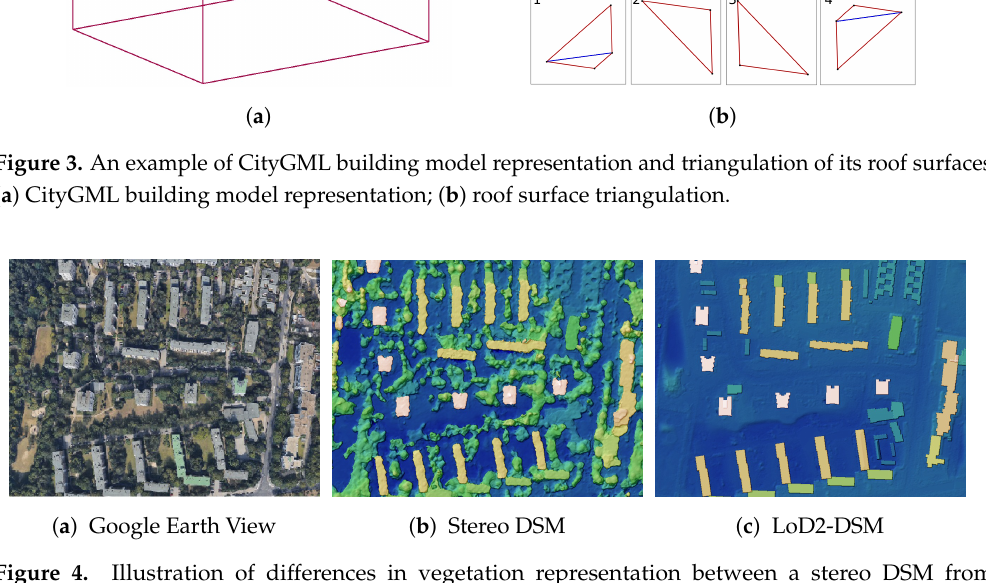
Figure 4. Illustration of differences in vegetation representation between a stereo DSM from WorldView-1 satellite and an artificially generated